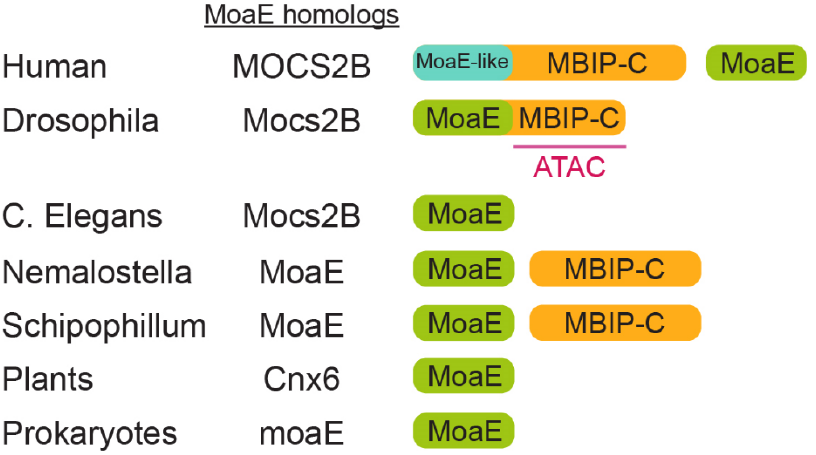
Figure 1. MBIP may be evolutionarily derived from MoaE. Schematic representation of phylogenetics of the MoaE and MBIP domains. The MBIP sequence in Drosophila Mocs2B/dMoaE, which is conserved in the C-terminus of human MBIP, is essential for incorporation into ATAC (red line).